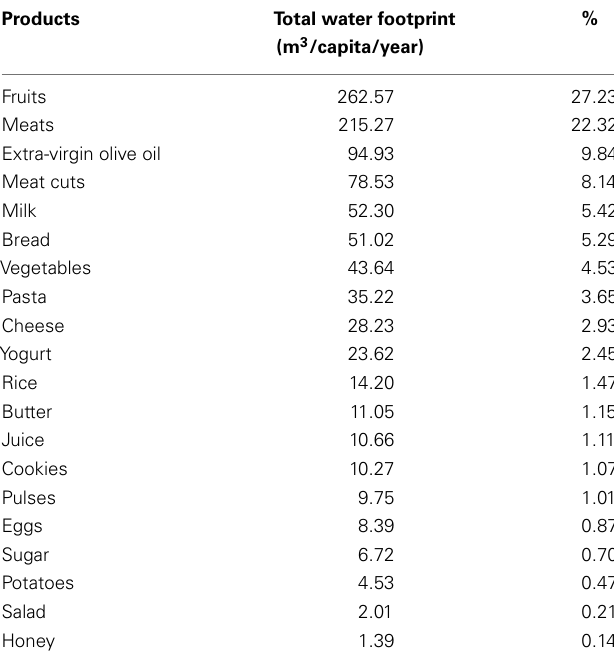
Table 5 |Top ten contributing products to food supply water footprint (%) in Italy andTurkey; 2006 .